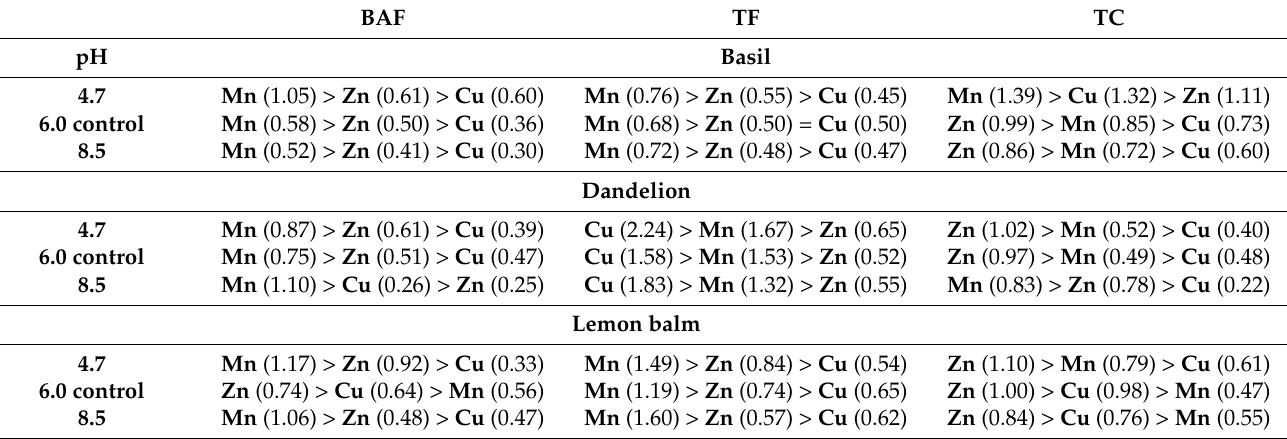
Table 3. Bioaccumulation factors (BAF), translocation factors (TF) and transfer coefficients (TC) calculated for basil, lemon balm and dandelion, respectively. Elements are shown in decreasing order of particular factor. Each value is the average of the data from five